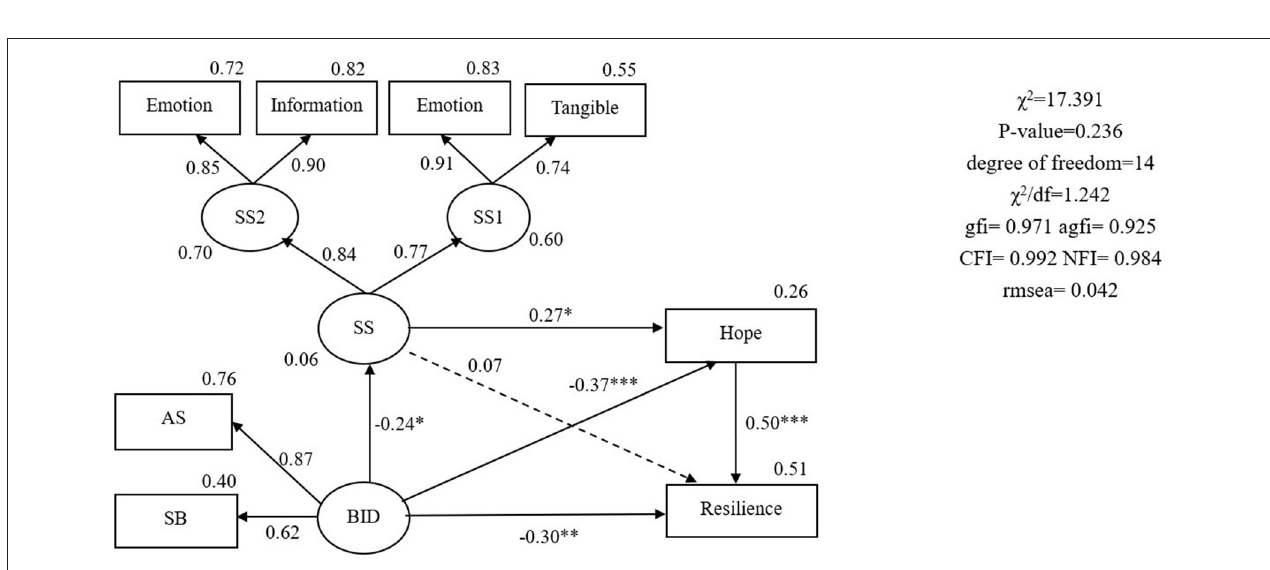
FIGURE 3 | The final model with standardized estimates. BID, body image distress; SB, social barriers; AS, physical appearance and sexual life; SS, social support; SSl, social support from family and friends; SS2, social support from health professionals; = latent variable; = measured variable; → = unidirectional path; * p < 0.05; ** p < 0.01; *** p <